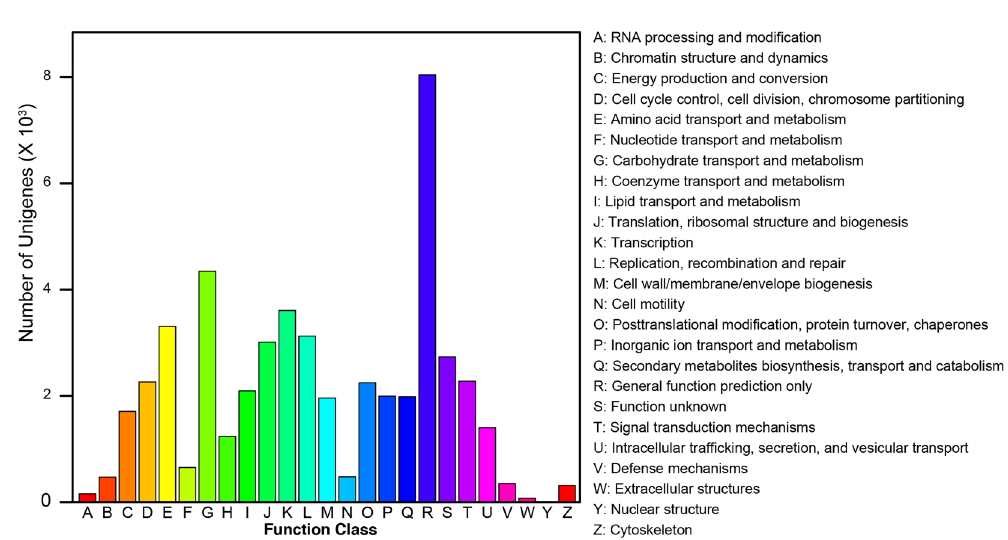
Figure 2. The KOG functional categories of S. latifolia